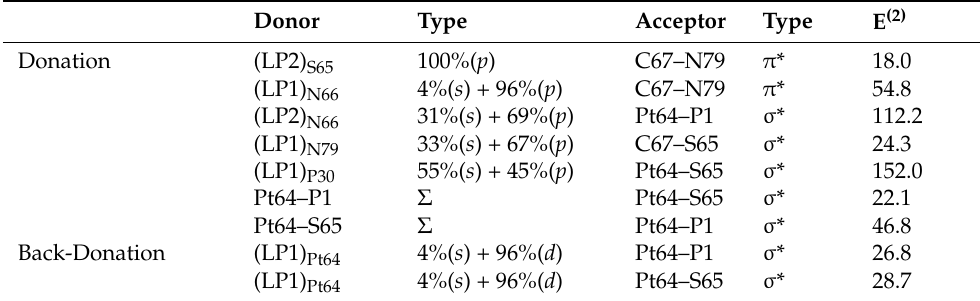
Table 8. Second-order perturbation energies (E (2) ) for charge transfers from donor to acceptor orbitals in [Pt(BPT)(PPh 3 ) 2 ] ( 5 ).